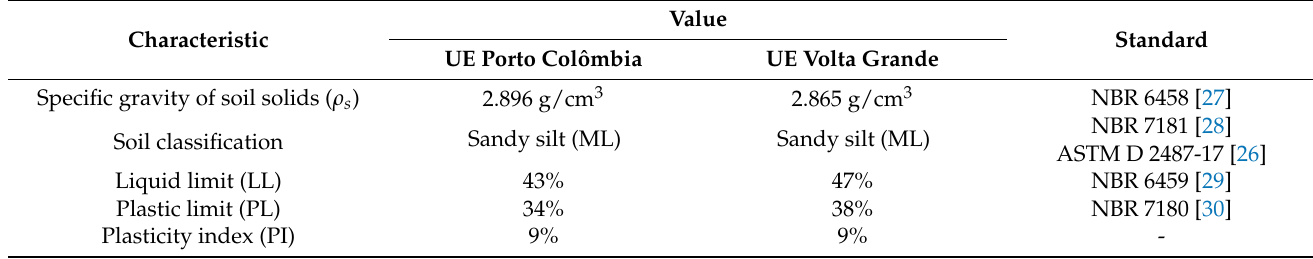
Table 1. Geotechnical characteristics of the experimental